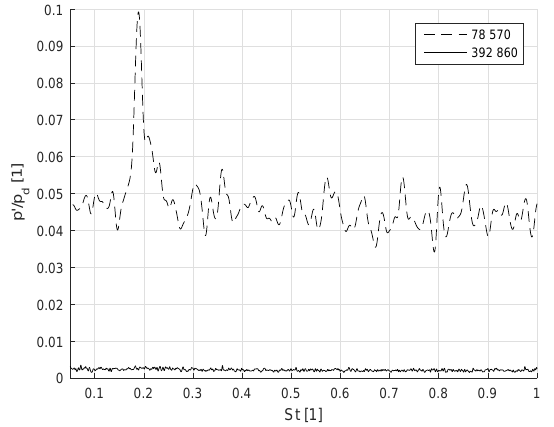
Fig. 5. The measured amplitude spectra normalized with dy- namic pressure for the lowest and the highest measured Reynolds numbers at the position x / D = 0 . 82 .